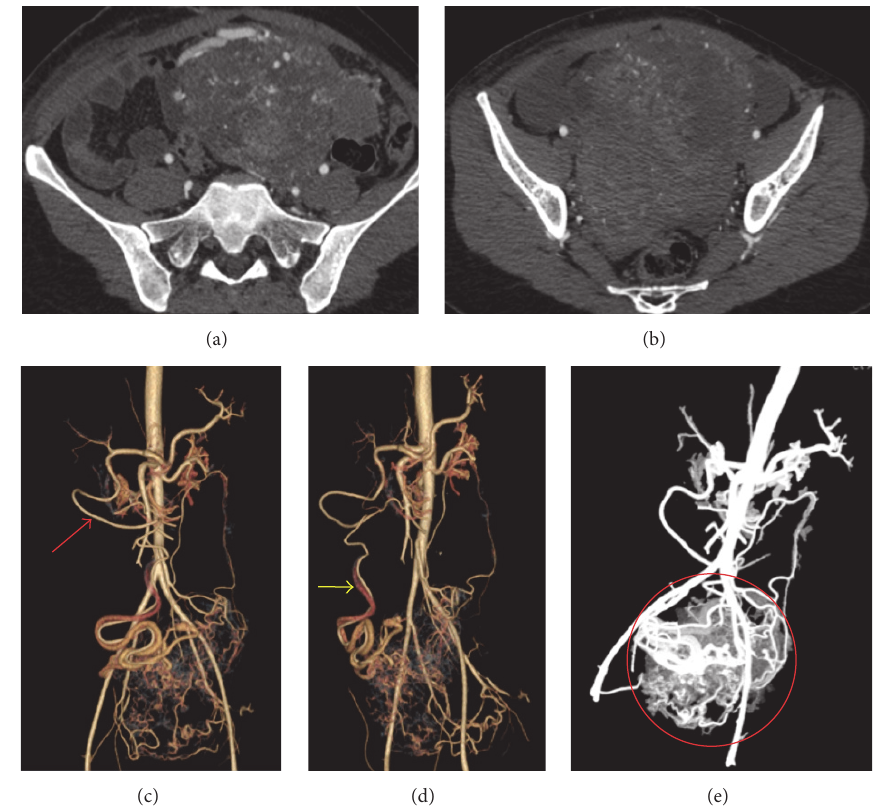
Figure 3: CT Angiography. Axial scan through the lower abdomen revealed a large heterogenous mass with multiple intralesional vascular channels ((a) and (b)); volume rendering reconstructed images ((c) and (d)) show a hypertrophied vascular channel (omental branch) arising from the right gastroepiploic artery (red arrow on (c)) which is encircled with a draining tributary which is drained into the superior mesenteric vein (yellow arrow on (d)); an angiographic reconstructed image (e) shows a highly vascular mass with multiple intralesional vascular channels (red